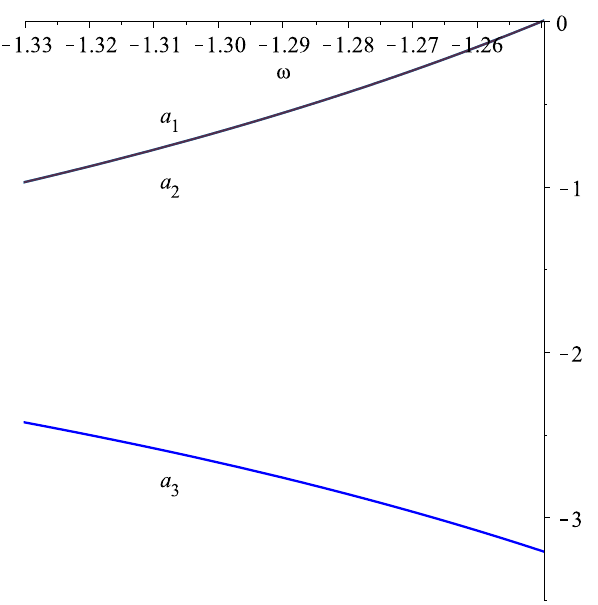
with Γ ( − 1 ) = 0. 5 The eigenvalues are shown in Fig. 5 for